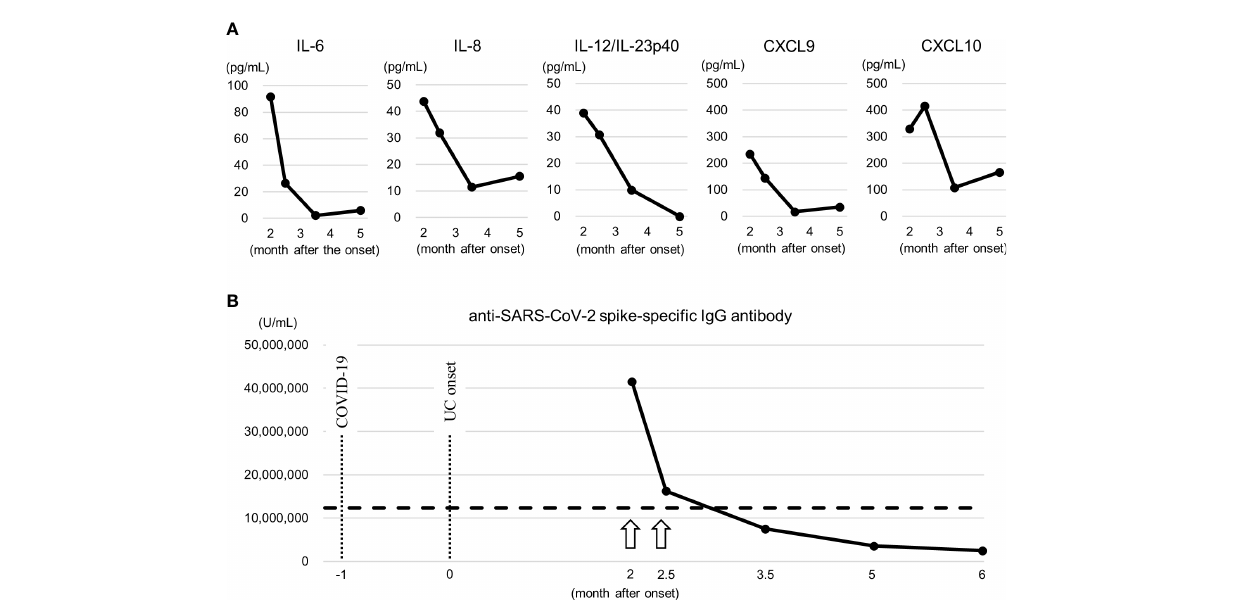
FIGURE 4 Serum cytokines and anti-SARS-CoV-2 spike IgG antibody titer. (A) Changes in serum cytokines and chemokines. These elevated cytokines and chemokines suggest the activation of cell-mediated, especially CD8 + T cells, and innate in fl ammatory immunity. They were measured by a Cytometric Bead Array (Becton Dickinson, Franklin Lakes, NJ, USA). (B) Changes in anti-SARS-CoV-2 spike IgG antibody titer. The arrow indicates the time of vaccination of BNT162b2. Dashed line represents highest value in the patient with MIS-C (13). Note that at the month 2.5, 1 day after the second vaccination, no increase in the titer exceeding the titer after the fi rst vaccination was con fi rmed, and no apparent exacerbation of clinical symptoms was noted at the time. They were measured by a human SARS-CoV-2 spike (Trimer) IgG ELISA kit (Thermo Fisher Scienti fi c, Waltham, MA, USA). COVID-19, coronavirus disease 2019; CXCL, chemokine (C-X-C motif) ligand; IL, interleukin; UC, ulcerative